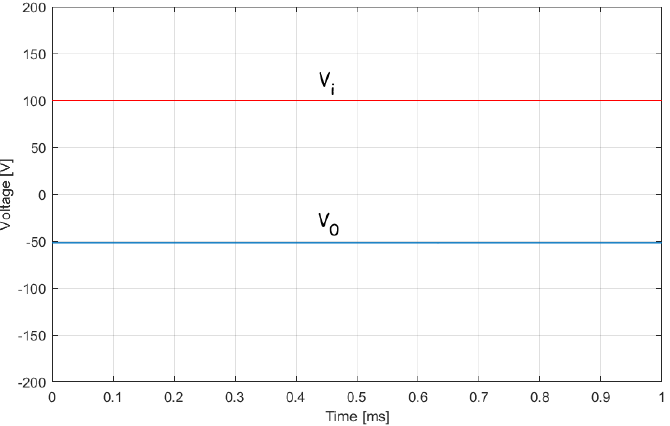
Figure 5. Simulation results of the input and inverted output voltage in buck mode.